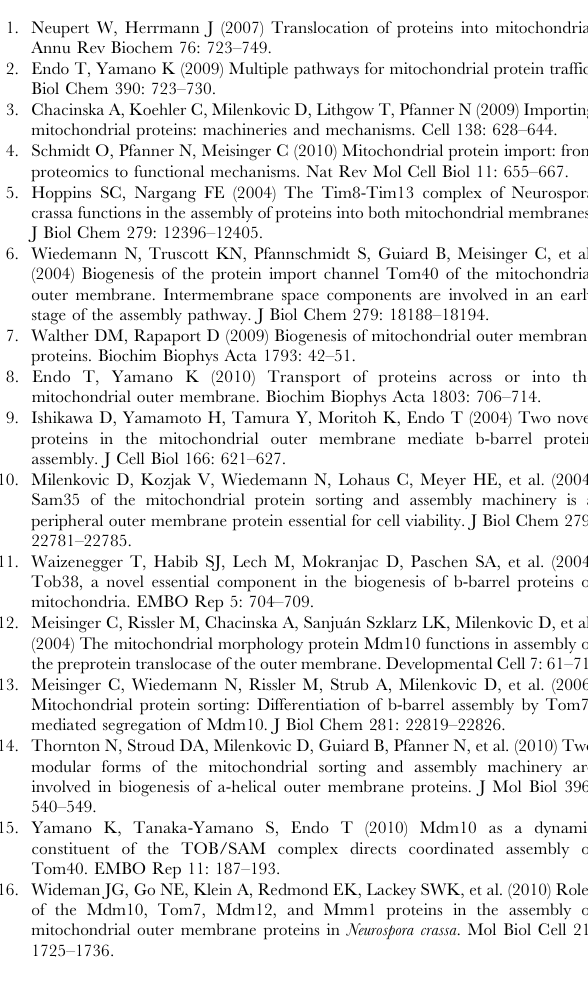
presence of histidine and fpa to reduce levels of Tob37 and Tob38. Import and assembly assays were as described in the legend to Fig. 2. (A) Assembly of Tom40. (B) Assembly of porin. (C) Import of F 1 b and AAC. (D) Assembly of Tom22. (PDF) Figure S2 Alignments of Neurospora crassa (Nc), Sac- charomyces cerevisiae (Sc), and Homo sapiens (Hs) Tob37 and Tob38 proteins. *, identical residues; :, conserved substitutions; ., semi-conserved substitutions. For the Tob37 alignment, the yellow highlight shows TMD1 in the N. crassa protein and the TMD of the H. sapiens protein, and the blue highlight shows the CHD of the N. crassa